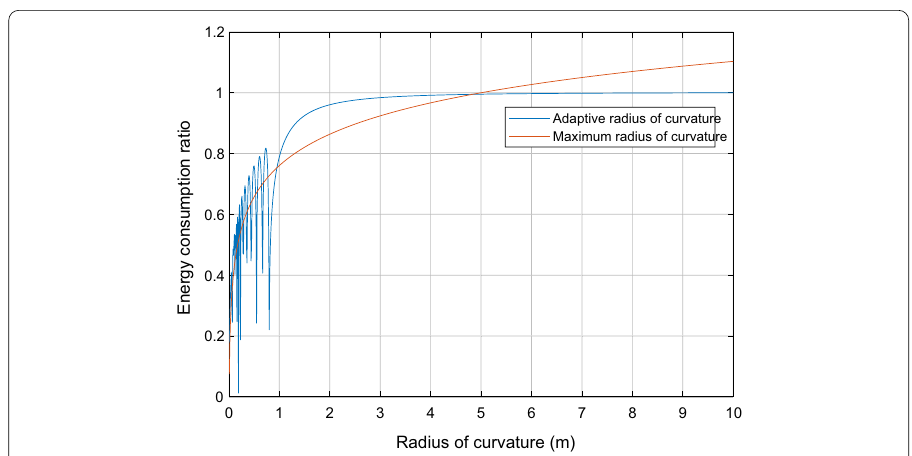
Fig. 10 Communication energy consumption under desire inter-vehicle distance 5